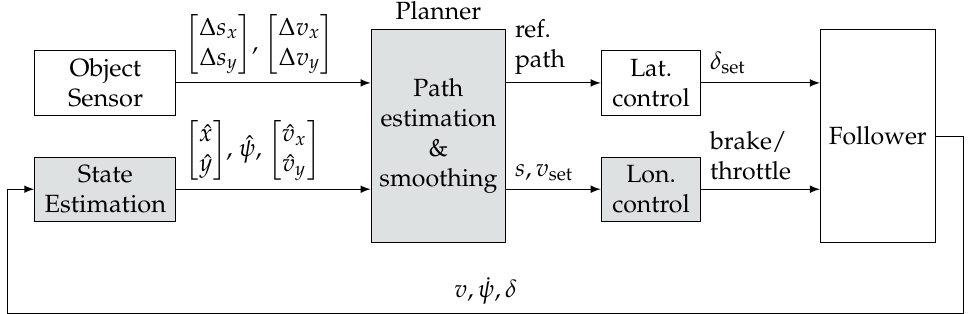
Figure 1. System architecture of the developed vehicle-following system. Shaded components are addressed in this paper, while the main contribution is regarding the Planner